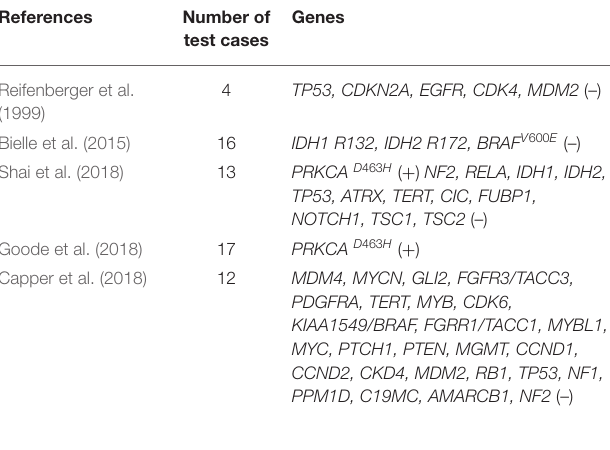
TABLE 2 | Causes of sodium homeostasis disorders after craniocerebral